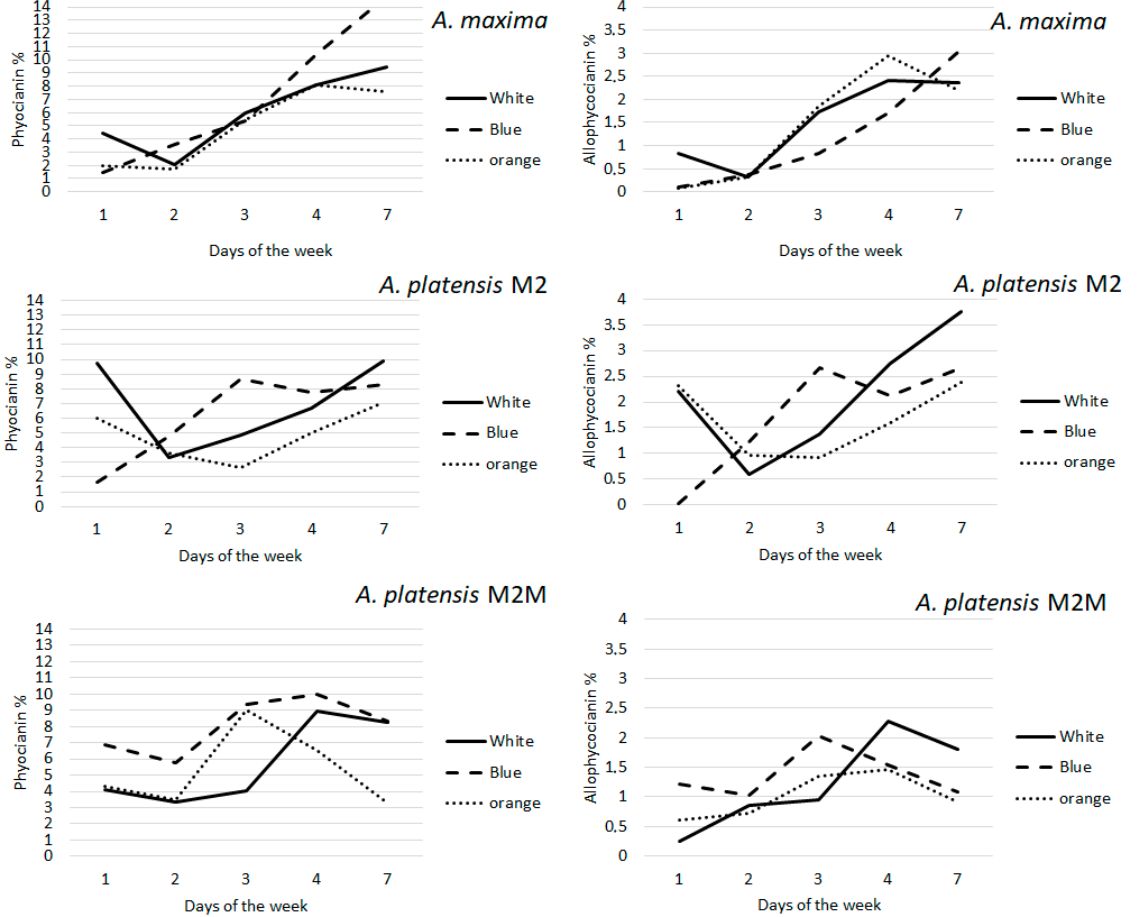
Figure 3. Phycocyanin and allophycocyanin amounts (g 100 g − 1 ± RSD DW) after exposing the three selected strains to the irradiation lamps: white, orange and blue.